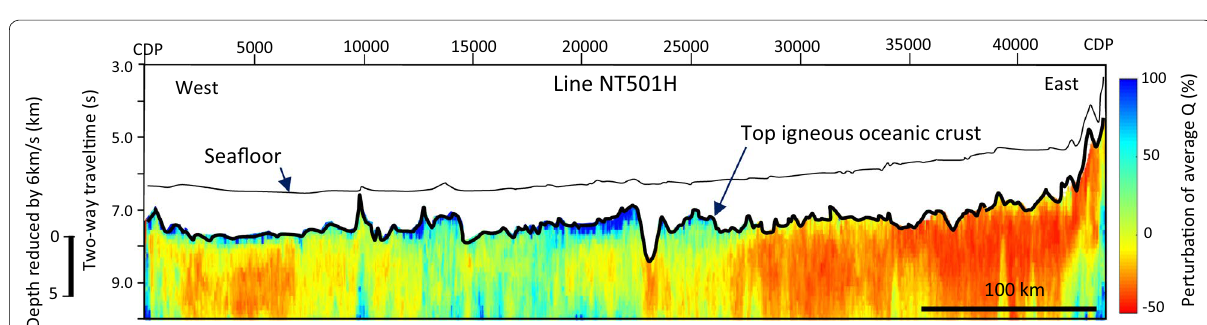
Fig. 6 Seismic attenuation profile of the NT501H line. The numerals on the top horizontal axis of the figure represent CDP numbers, and the vertical axes indicate two‑way travel time in seconds. Left side depth scale is computed from the two‑way travel time with reduction velocity of 6 km/s. The color scale represents the percentage deviation from the median value of the average Q for the entire